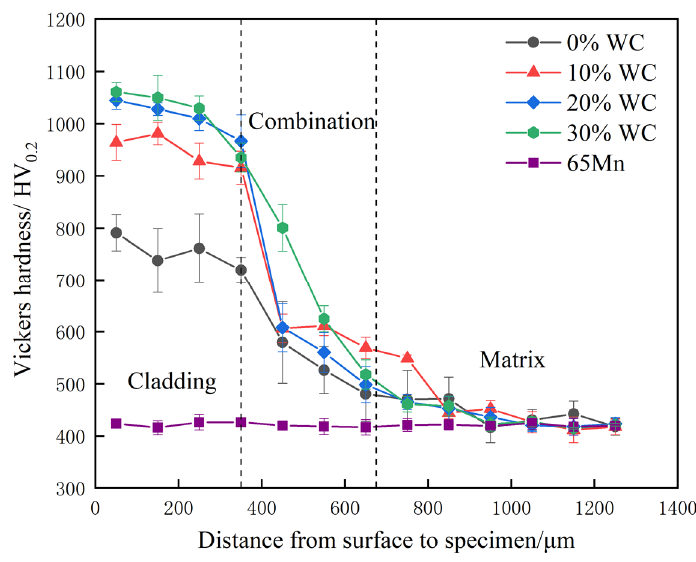
Figure 5. Effect of WC content on the microhardness of cladding coating.